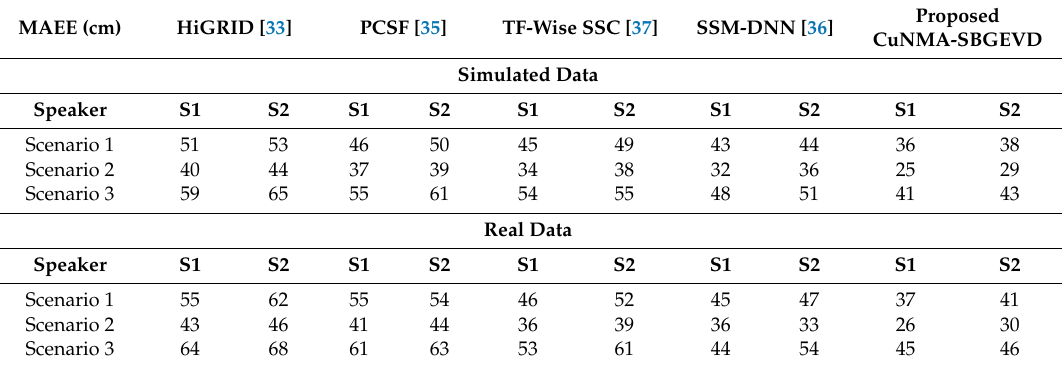
Table 2. The mean absolute estimation error (MAEE) comparison between the proposed